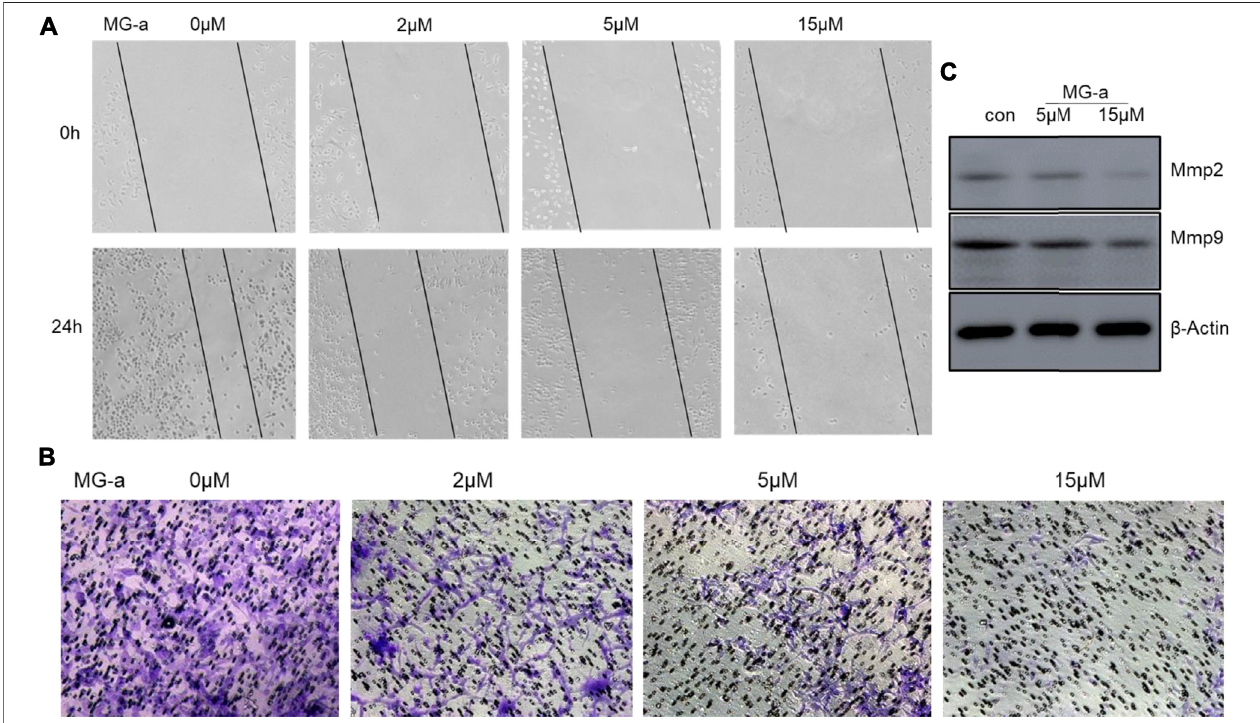
FIGURE 6 | α -mangostin suppressed the migration and invasion of TNBC Cells in Vitro . (A) The cell migration ability was determined by wound healing assay. (B) The cell migration and invasion were determined by Transwell assay. (C) The expression levels of Mmp2 and Mmp9 were determined by western blotting analysis in MDA-MB-231 cells after α -Mangostin